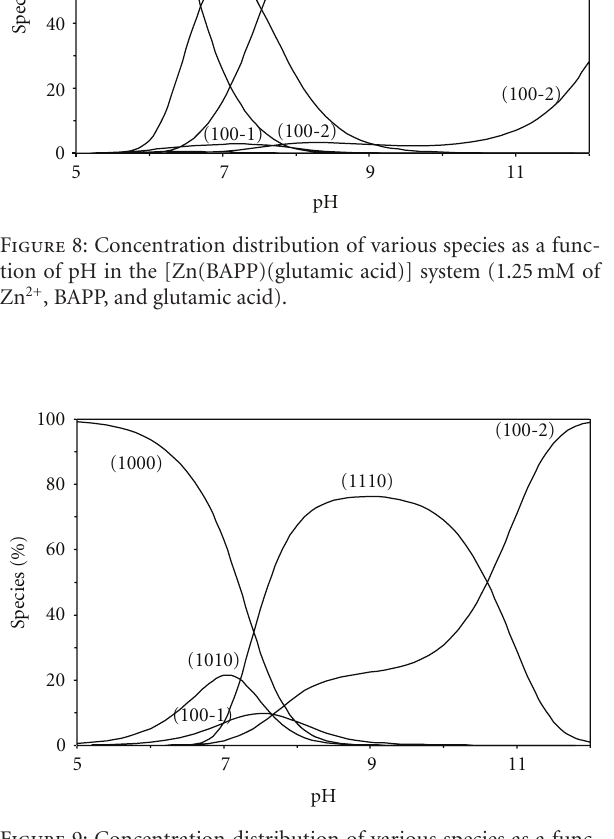
Figure 9: Concentration distribution of various species as a func- tion of pH in the [Zn(BAPP)(glycinamide)] system (1.25mM of Zn 2+ , BAPP, and